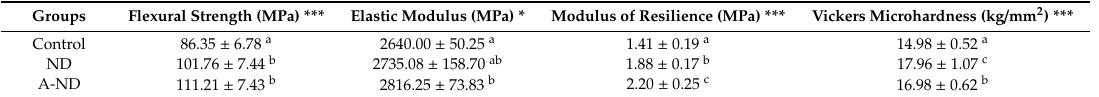
Table 2. Mean and standard deviation values of flexural strength, elastic modulus, modulus of resilience and Vickers microhardness for di ff erent groups after